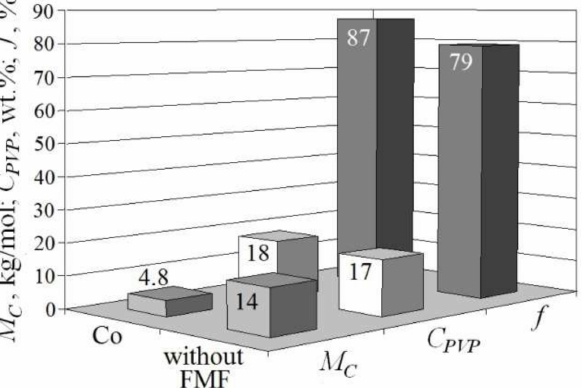
Figure 3. The effect of FMF on structural parameters of pHEMA-gr-PVP copolymers (HEMA:PVP = 80:20 mass parts, [Co] = 10 wt.%): grafting efficiency ( f PVP ), PVP content ( C PVP ) and molecular weight between crosslinks in polymer network ( M C ).